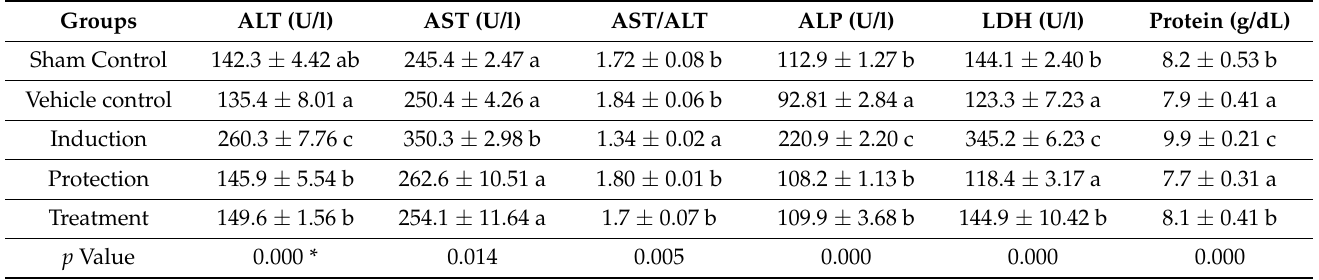
Table 3. Effect of different treatments on the liver function